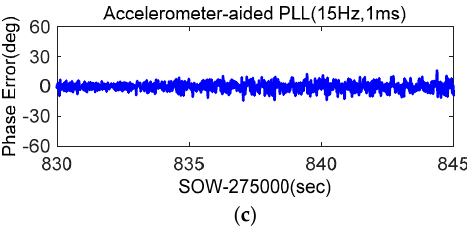
Figure 18. Phase errors of high elevation angle satellite G26 based on shake table tests; ( a ) Phase error of second-order PLL; ( b ) Phase error of third-order PLL; ( c ) Phase error of accelerometer-aided second-order PLL.